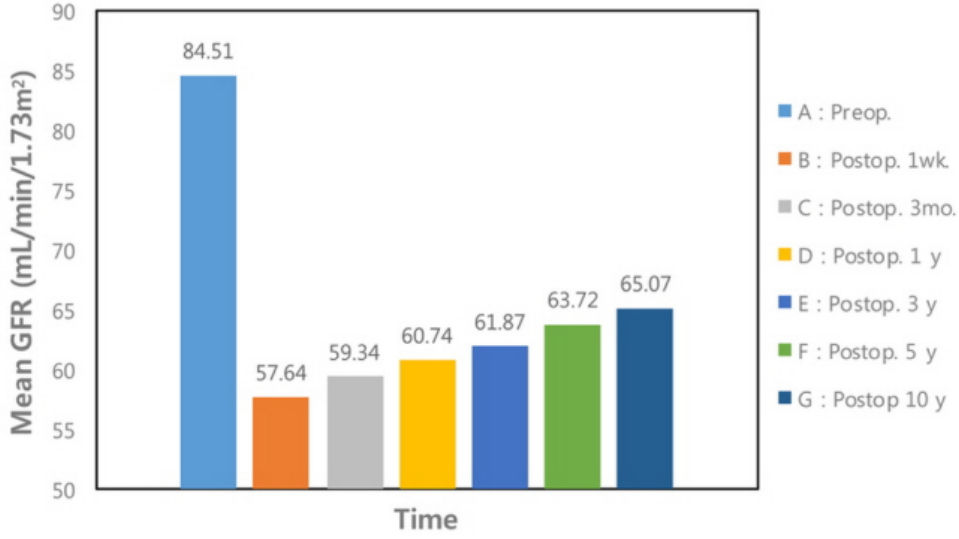
Figure 1. Changes in mean GFR before and after radical nephrectomy in patients with renal cell carcinoma. GFR: Glomerular filtration rate, Postop: Postoperative, Preop: Preoperative.